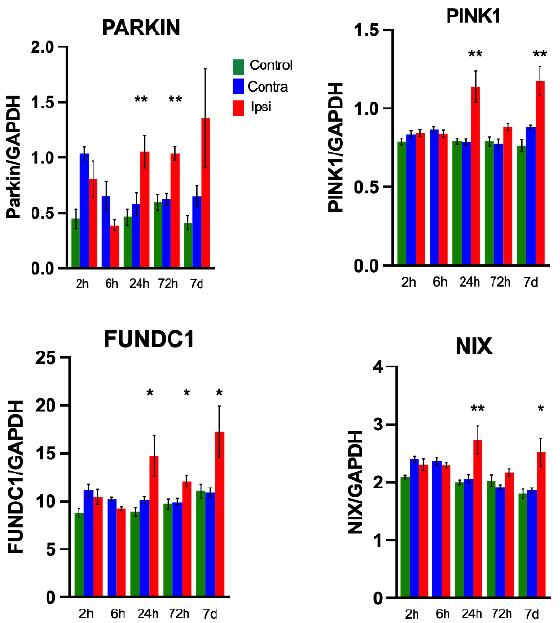
Figure 9. RT ‐ PCR of mitophagy genes Pink1, Parkin, Nix, FUNDC1. N = 6 +/ − SEM in duplicate. * p ≤ 0.05, ** p ≤ 0.01. Statistics compared by Mann–Whitney Test between the control and respective ipsilateral hemisphere.